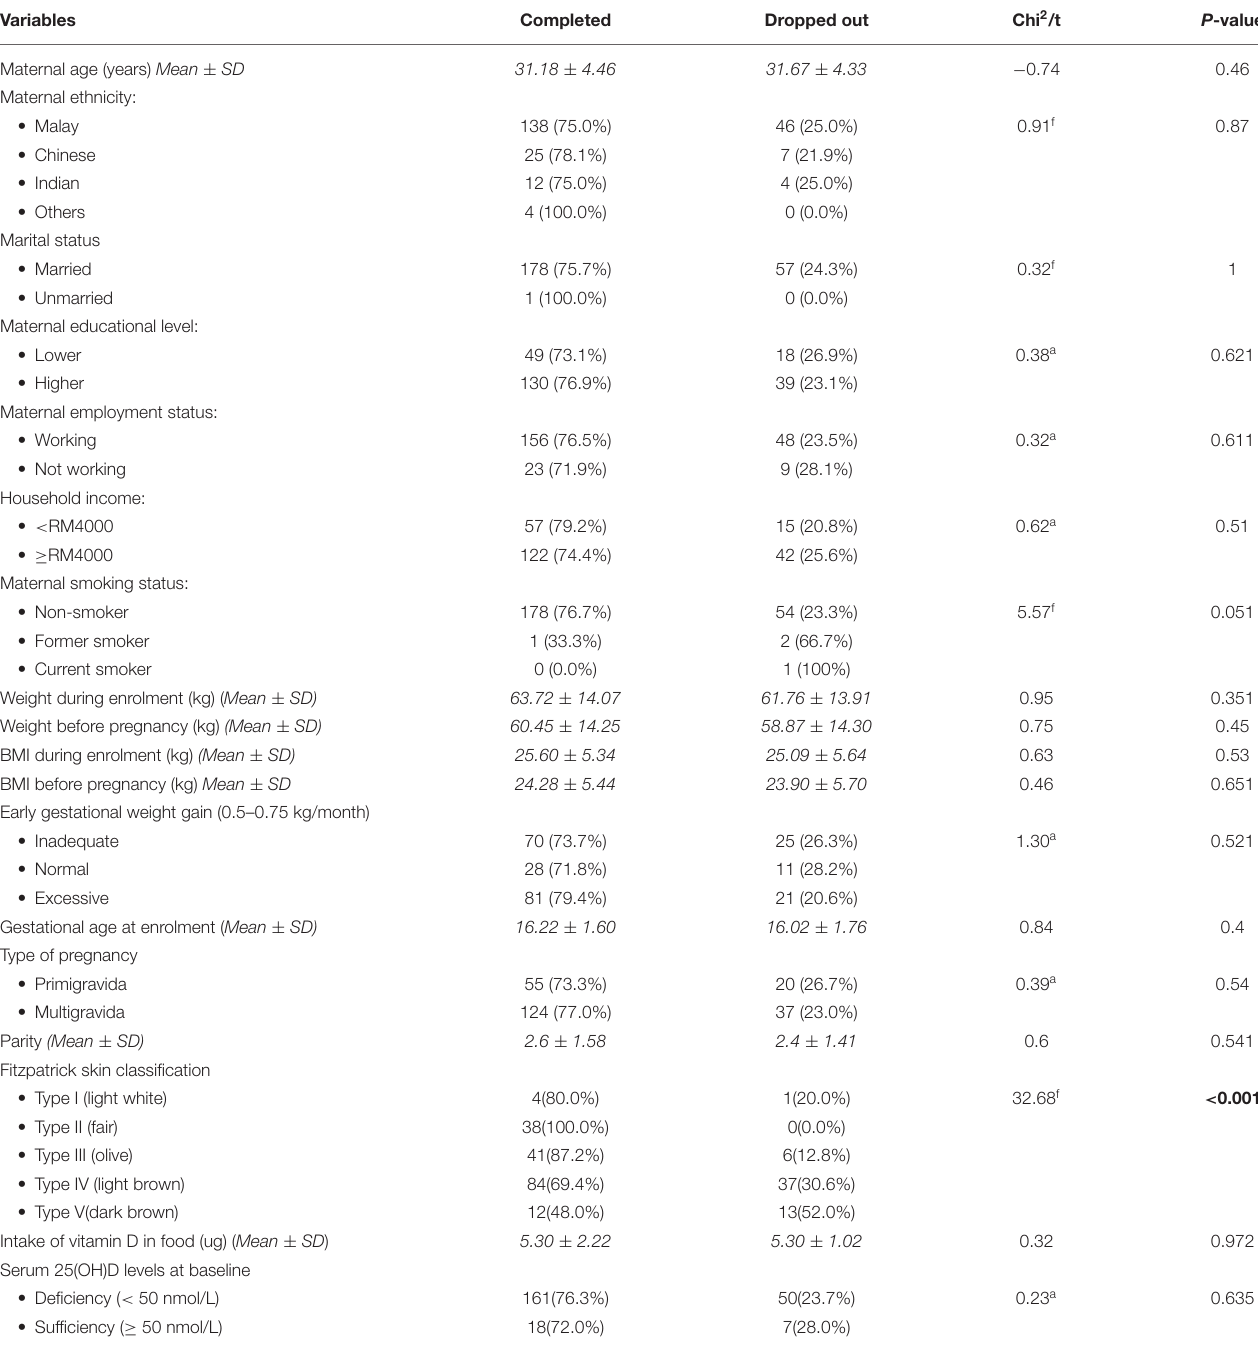
TABLE 1 | Baseline characteristics of pregnant women who completed the study ( n = 179) and those who dropped out ( n = 57). Variables Completed Dropped out Chi 2 /t P -value Maternal age (years) Mean ±